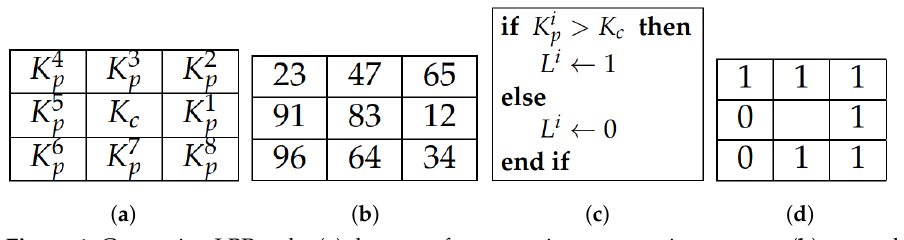
Figure 1. Generating LBP code: ( a ) the way of representing contents in a pattern; ( b ) a sample pattern; ( c ) the pseudo-code for LBP; ( d ) LBP